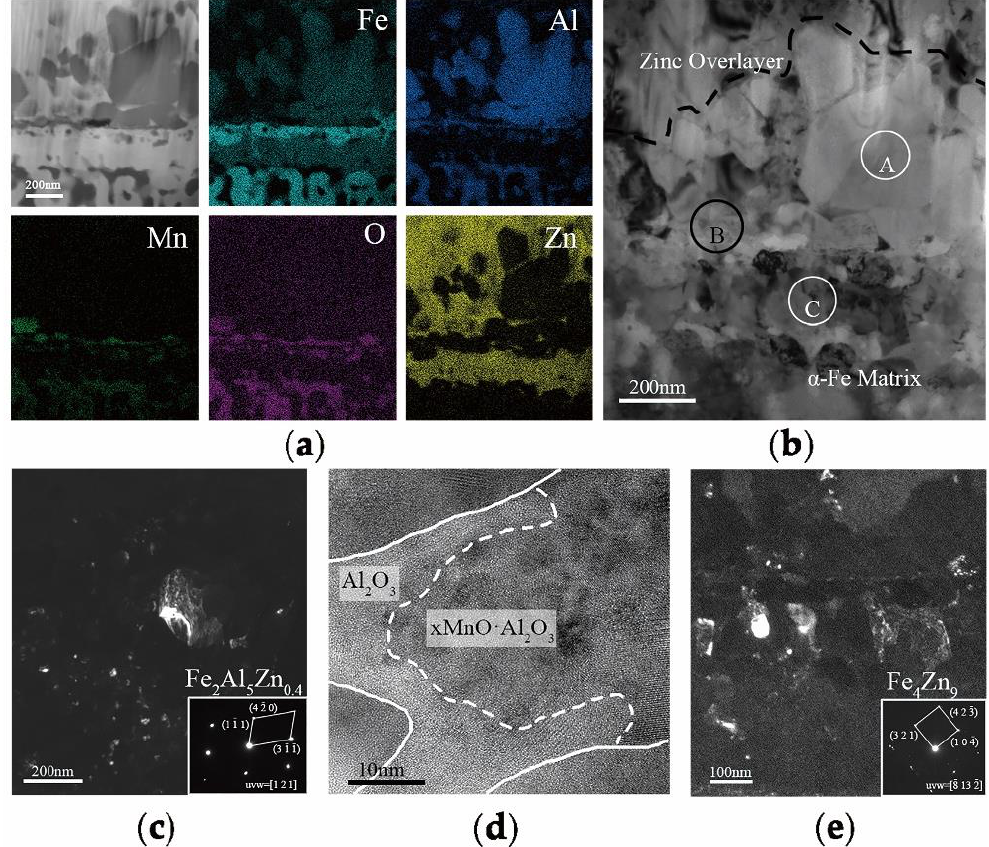
Figure 4. ( a ) STEM cross-sectional elemental maps of the coating/substrate interface and subsurface of the galvanized 3Mn steel annealed under the 243 K ( − 30 °C) DP process atmosphere. ( b ) TEM micrograph of the area shown in ( a ). ( c ) Enlargement of the inhibition layer corresponding to zone A in ( b ). ( d ) Lattice image of the interface between the amorphous Al 2 O 3 and the crystalline xMnO · Al 2 O 3 corresponding to zone B in ( b ). ( e ) Enlargement and lattice image of the area corresponding to zone C in ( b ).